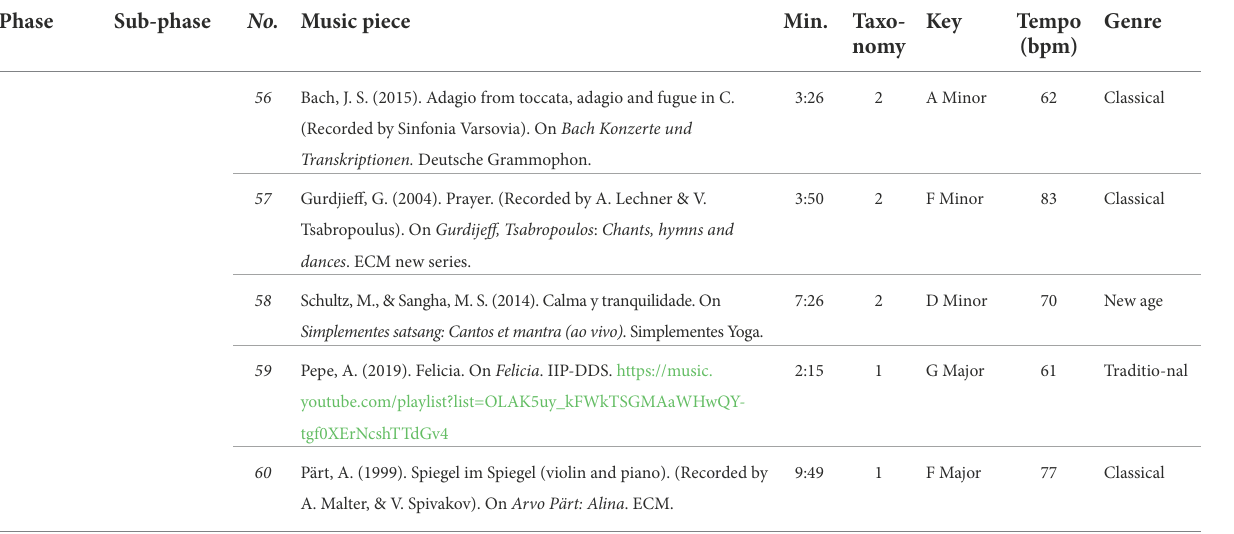
The table shows a full overview of music pieces in the music program and their corresponding taxonomy ratings together with duration, tempo, key and genre of each music piece. The music program is a mix of genres: 43.33% Classical, 23.33% Contemporary, 15% Traditional (world/folk music), and 18.33% New age music. The Ascent phase is characterized by pieces in Major keys with an increasing tempo (average 66 bpm), and a mix of genres. The Peak phase consists of pieces from mostly classical genres in Minor keys, with an average tempo of 72 bpm, including two new-age pieces that use tempo shifts up to 121 bpm. A mix of Major and Minor keys and genres and a descending tempo (average 61 bpm) are prominent in the longer Descent phase, where most Traditional and Film Music pieces are